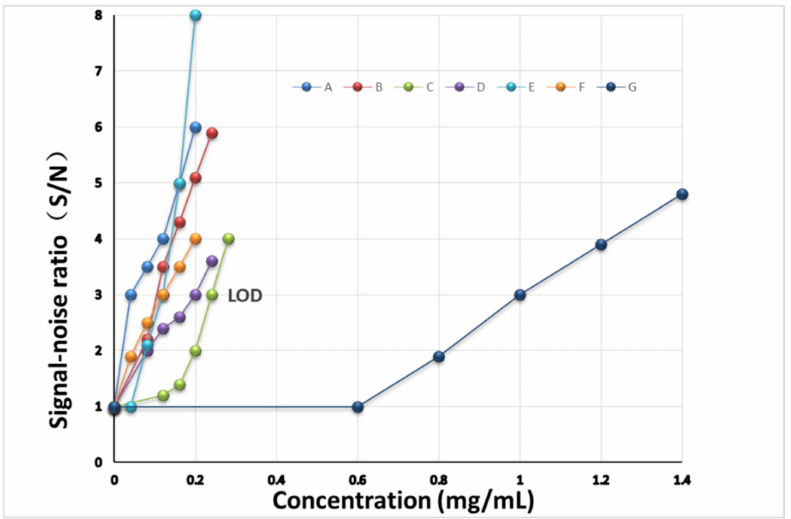
Figure 5. LOD of the seven pesticides by TLC-RIM. (A, B, C, D, E, F, and G: Abamectin, Methomyl, Carbendazim, Imidacloprid, Chlorothalonil, Azoxystrobin, and Acetamiprid, respectively).